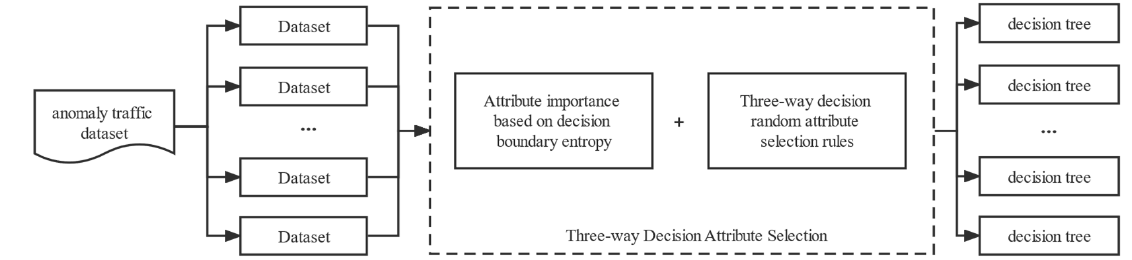
Figure 4. Three a tt ributes random selection algorithm. Figure 4. Three attributes random selection